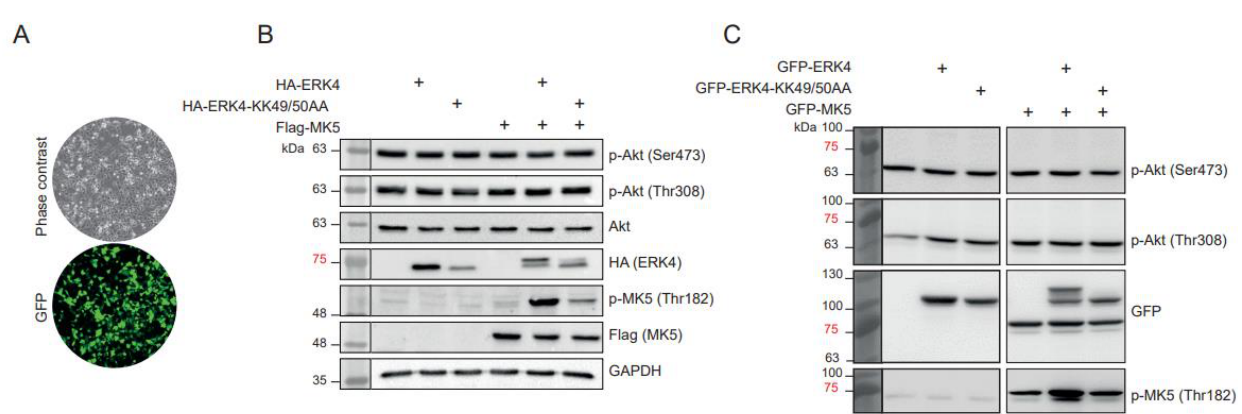
Figure 2. ERK4 catalytic activity has no impact on the phosphorylation of AKT on Thr308 and Ser473. ( A ) Hs578T TNBC cells were transfected with a GFP-expressing plasmid to show the high yield of transfection of the cells. ( B ) Hs578T cells were transfected with HA-ERK4 or catalytically-inactive HA-ERK4 KK49/50AA with or without Flag-MK5. Phosphorylation of endogenous AKT on Thr308 and Ser473 or of ectopically expressed Flag-MK5 was analyzed by immunoblotting with phospho-specific antibodies. Expression of HA-ERK4 was measured with anti-HA antibody. ( C ) HEK 293T cells were transfected with GFP-ERK4 or catalytically-inactive GFP-ERK4 KK49/50AA with or without GFP-MK5. Phosphorylation of endogenous AKT on Thr308 and Ser473 or of ectopically expressed GFP-MK5 was analyzed by immunoblotting with phospho-specific antibodies. Expression of GFP constructs was controlled with anti-GFP antibody.